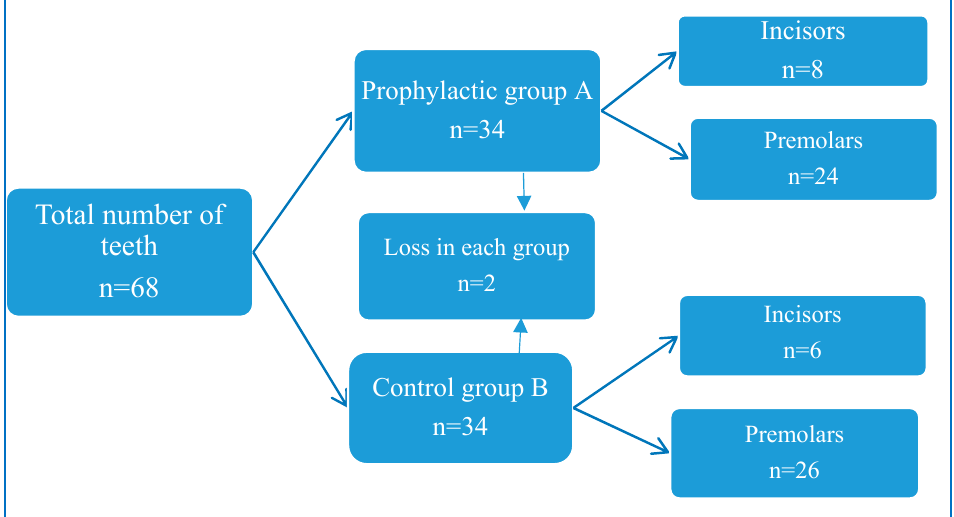
Figure 1. Representation of the distribution of groups and subgroups of teeth in this study.